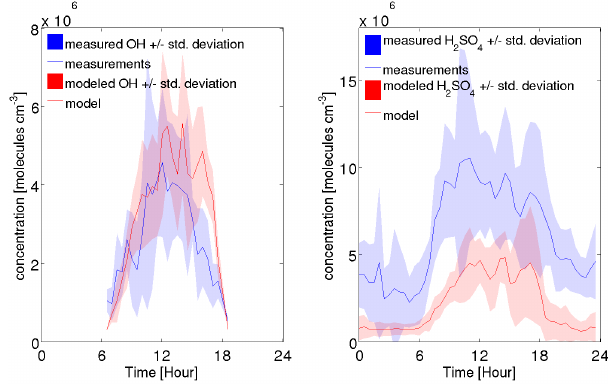
Figure 6. Averaged modeled and measured diurnal cycles of OH concentration (left) and sulfuric acid concentration (right). Mea- surement average (line) and ± 1 standard deviations (shaded area) are in blue; model average (line) and ± 1 standard deviations (shaded area) are in red. The comparisons for OH and sulfuric acid are made at 2m.